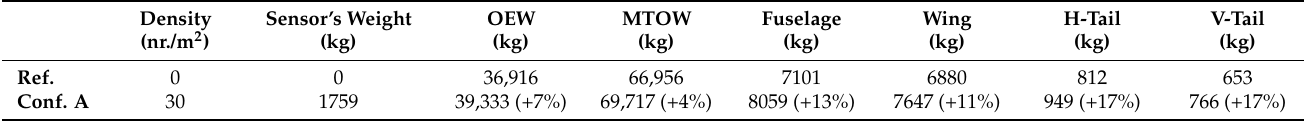
Table 6. Weight estimation for different components.